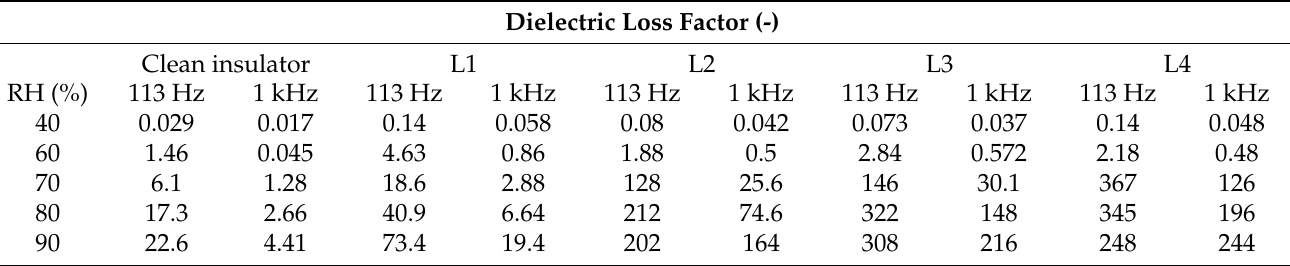
Table 4. Dielectric loss factor measured data at frequencies 113 Hz and 1